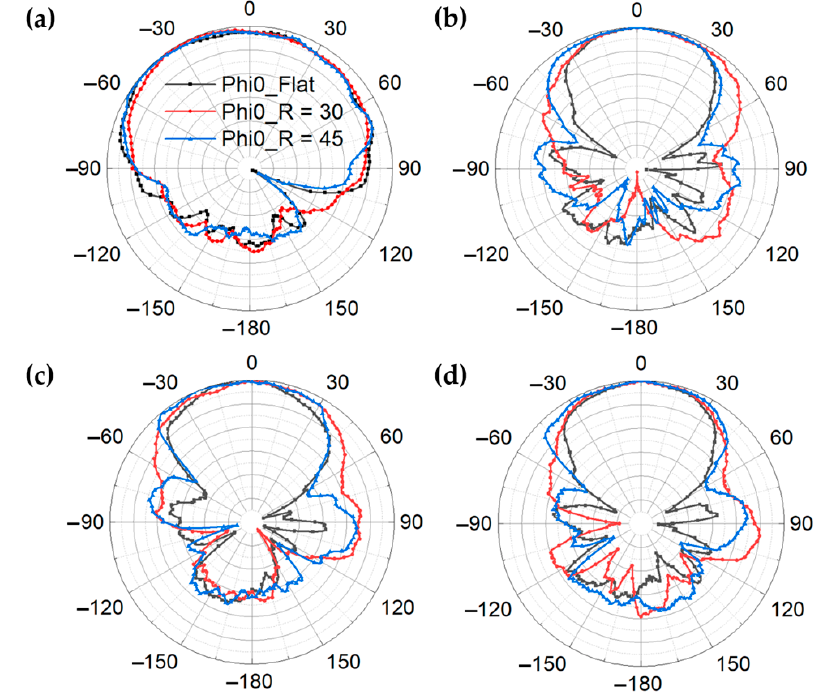
Figure 5. ( a – d ) Measured radiation patterns of the bent GAF antenna at different frequencies of ( a ) 2.45 GHz; ( b ) 5.5 GHz; ( c ) 6.0 GHz; ( d ) 6.5 GHz. As shown in Figure 6a, the proposed GAF antenna is used in the router, which has the advantages of high transmission rate, easy to conformal and light weight. Figure 6b depicts that the GAF antenna router is fabricated by replacing the original copper antenna of the router with the GAF antenna. By conforming the GAF antenna to the surface of the router, space utilization can be improved and miniaturization can be achieved. The transmission rates and spectral power of the GAF antenna and copper antenna were measured in an anechoic chamber as shown in Figure 6c. It can be seen from Figure 6d,e that the GAF antenna has a transmission rate comparable to that of a copper antenna. Figure 6f shows that the spectral power of the GAF antenna is greater than the original copper antenna in the router, which means a higher signal-to-noise ratio and a longer transmission range can be